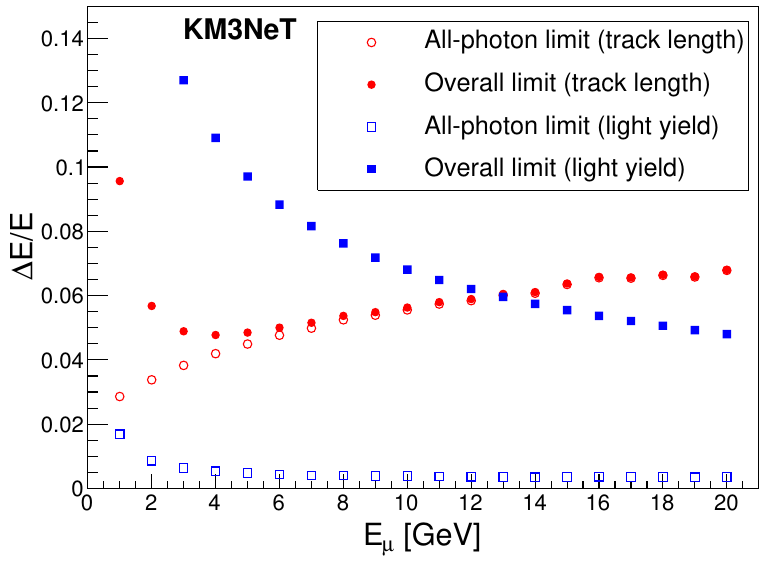
Figure 22 . Limits on the relative muon energy resolution (RMS) as a function of muon energy E (cid:22) for the muon track length method (red circles) and the total light yield method (blue squares). Resolutions are shown for the all-photon limit (hollow markers) and overall limit ((cid:12)lled markers).